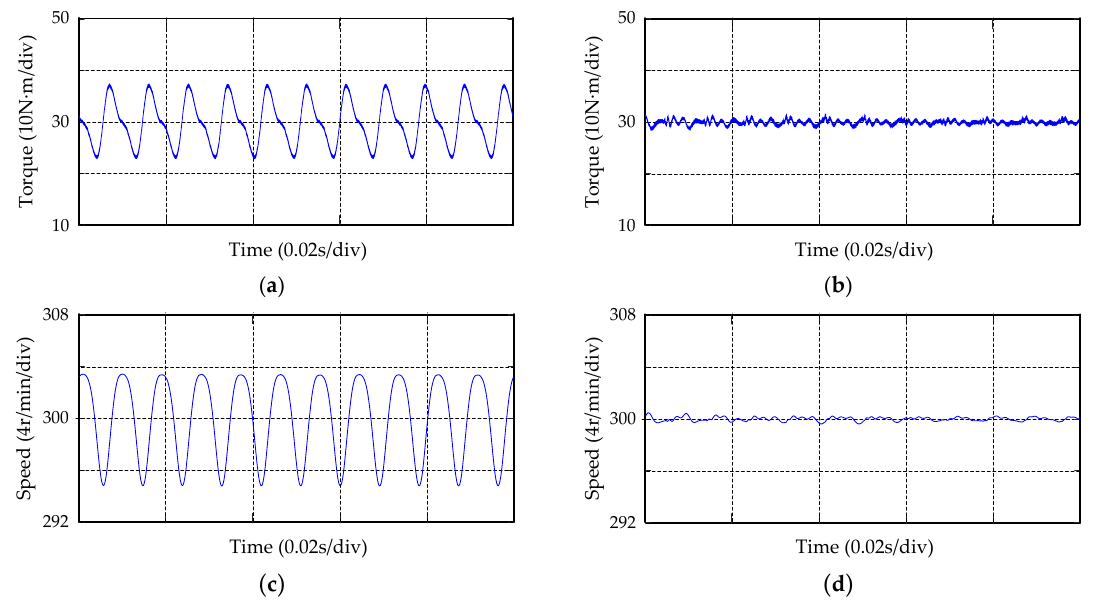
Figure 14. Amplified waveforms of torque and speed of five-phase PMSM: ( a ) Torque waveform of removing faulty phase after short-circuit; ( b ) Torque waveform after adding RC; ( c ) Speed waveform of removing faulty phase after short-circuit; ( d ) Speed waveform after adding RC.